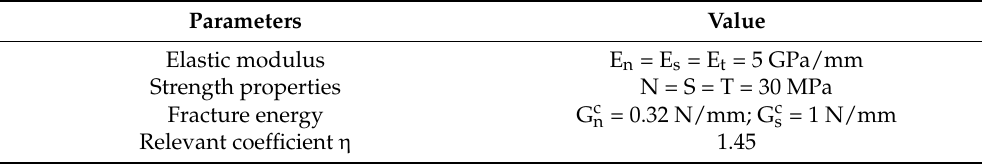
Table 2. Material properties of interface cohesive elements.